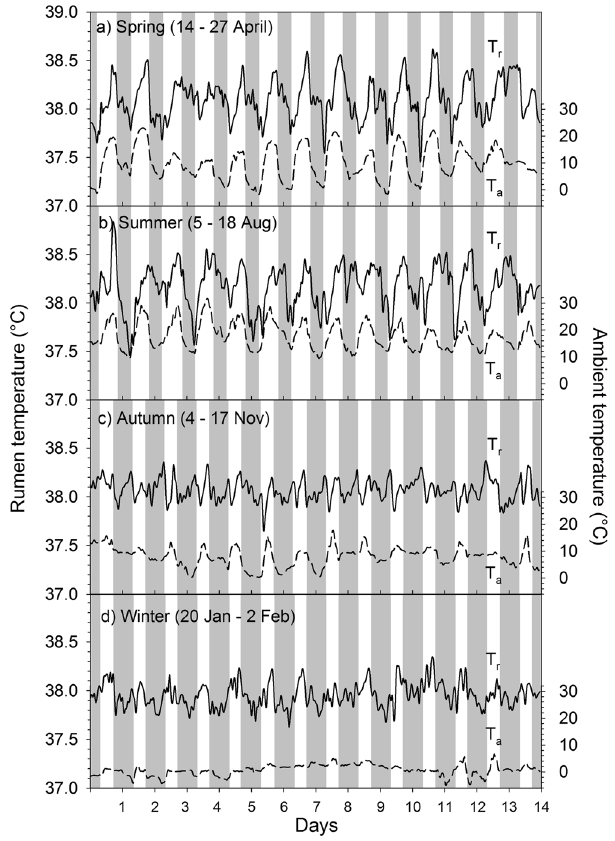
Figure 2. Rumen temperature in llamas. Data show the diurnal rhythm of ambient temperature (T a , dashed line) and average rumen temperature (T r , solid line) in adult non-pregnant llama dams (N = 7) during two weeks in four different seasons (spring, summer, autumn, winter) under central European climatic conditions. Grey shaded areas indicate night-phase. Axis range for T r and T a is the same for each